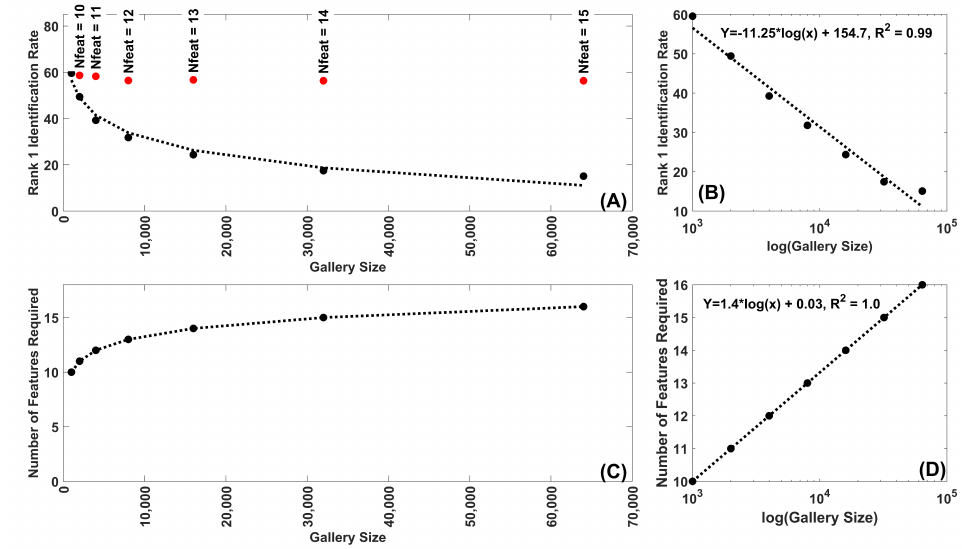
Figure 5. ( A ) Rank-1 IR as a function of gallery size for synthetic Band 8 features. Each dot represents the mean of 30 repetitions. The black dots are the Rank-1 IR for 10 features for the following gallery sizes: 1000, 2000, 4000, 8000, 16,000, 32,000, 64,000 subjects. The red dots represent the Rank-1 IR for feature numbers greater than 10 which are chosen to produce a Rank-1 IR most similar to that for 10 features and 1000 subjects. ( B ) Same data as ( A ) plotted on a log(Gallery size) scale. Note the fit of the decline to a linear function of log(Gallery Size). ( C ) Plot of the number of features required for gallery sizes greater than 1000 to match the Rank-1 IR for 10 features, 1000 subjects. ( D ) Same data as ( C ) plotted on a log(Gallery size) scale. Note the fit of the increase to a linear function of log(Gallery Size). In this case a linear equation in log(Gallery Size) was able to match the results perfectly (r-squared =